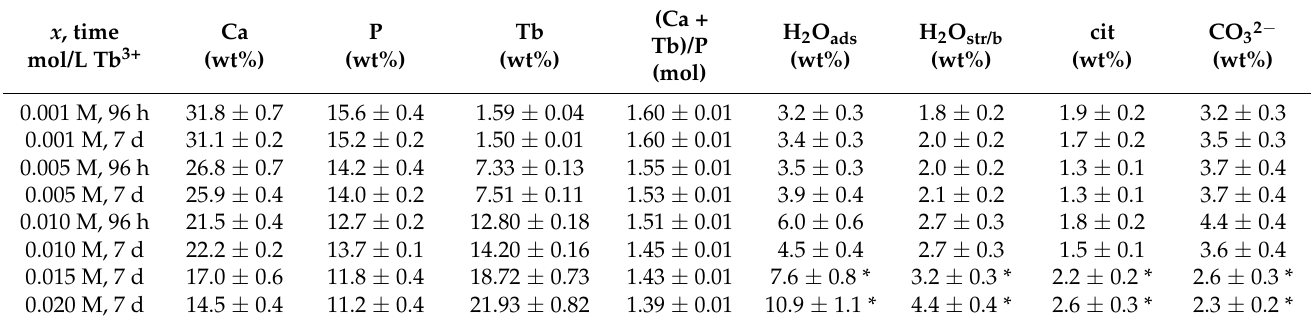
Table 1. Chemical composition determined by ICP and TGA analyses of most matured Tb 3+ :cit-cAp samples prepared by varying x from 0.001 to 0.020 M Tb 3+